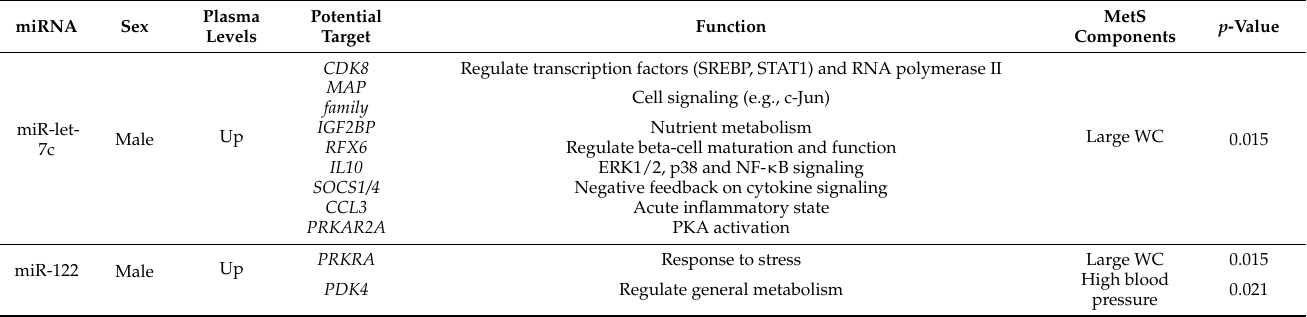
Figure 4. Levels of miRNA in plasma from adults with normal or low HDL ‐ c concentrations . The sample sizes were as follows: miR ‐ 16, miR ‐ 375 and miR ‐ 486 (Normal HDL ‐ c n = 92|Low HDL ‐ c n =